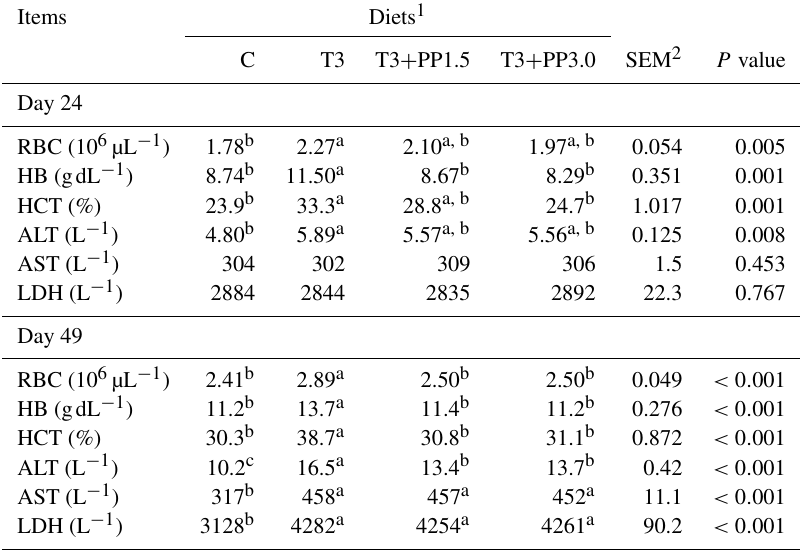
Table 5. Effects of dietary treatments on superoxide dismutase (SOD), catalase (CAT), and glutathione peroxidase (GPx) activities, and malondialdehyde (MDA) concentrations of plasma in broiler chickens at 24 and 49 days of experiment. Items Diets 1 C T3 T3 + PP1.5 T3 + PP3.0 SEM 2 P value Day 24 SOD (mL − 1 ) 155 a 131 c 145 b 1.8 < 0 . 001 CAT (mL − 1 ) GPx (mL − 1 ) 178 a 161 c 173 b 174 a, b 1.3 < 0 . 001 MDA (nmolmL − 1 ) 3.53 b 0.134 0.002 Day 49 SOD (mL − 1 ) < 0 . 001 CAT (mL − 1 ) GPx (mL − 1 ) < 0 .